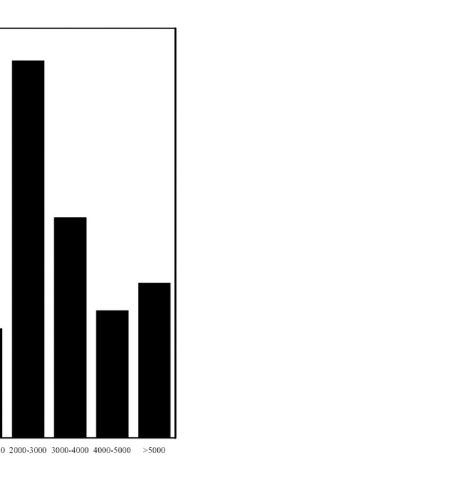
Fig 2. Length distribution of unigenes assembly for Rosa roxburghii Tratt.